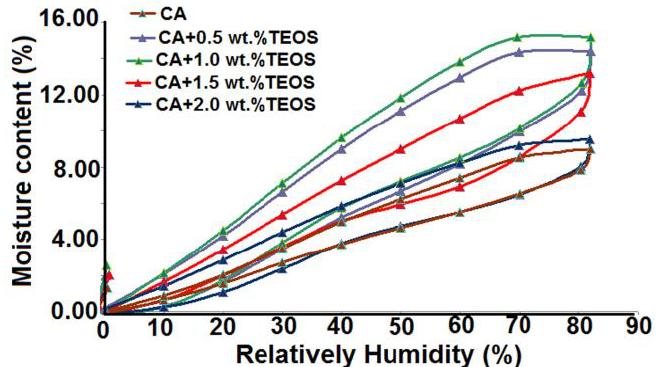
Figure 10. Sorption/desorption isotherms for the studied samples. Table 6. Surface parameters evaluated based on adsorption/desorption isotherms: water vapor sorption capacity; W, final weight; pm r